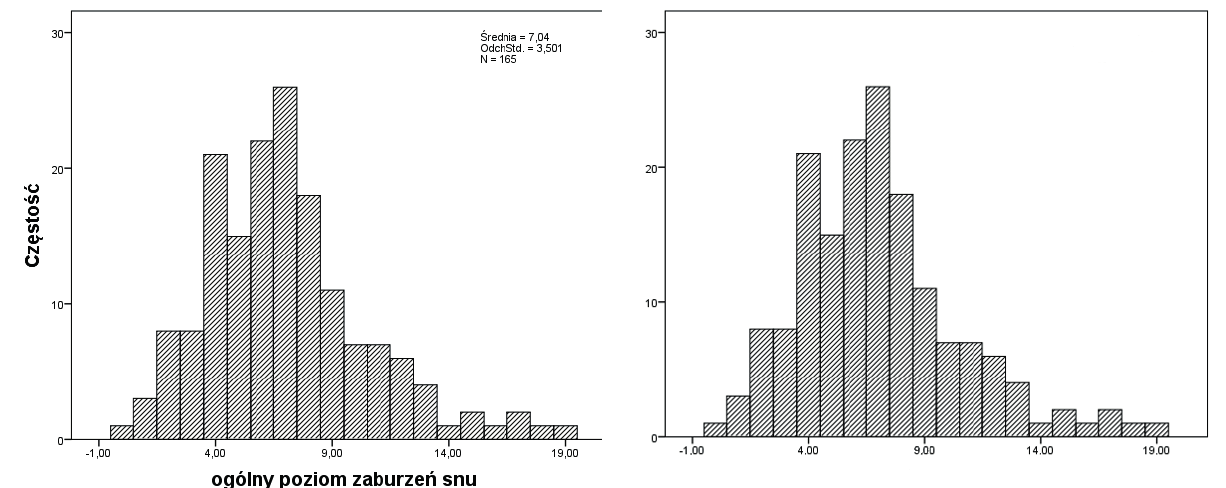
Figure 4. Summary of the Pittsburgh Sleep Quality Questionnaire (PSQI) results.